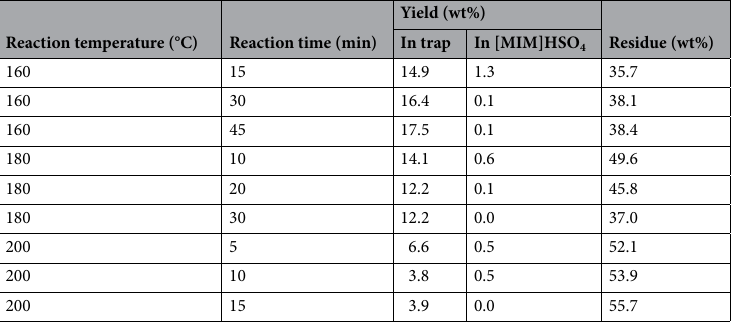
Table 4. Yields of recovered 5-HMF from wood (0.03 g; moisture content 4.8%) by vacuum steam distillation with [MIM]HSO 4 (1 g) at 2.5 kPa.